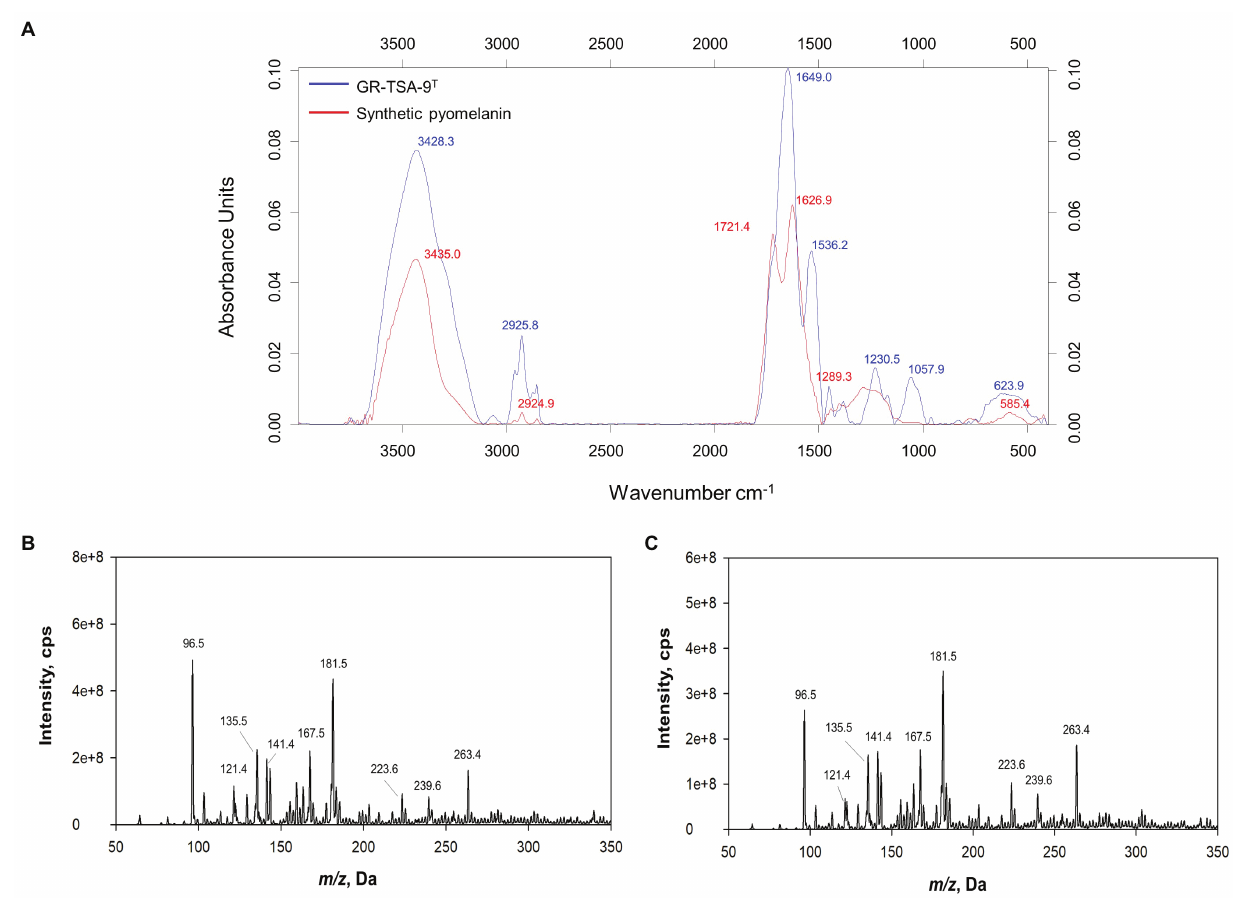
FIGURE 5 | Analysis of pyomelanin from strain GR-TSA-9 T . (A) FT-IR spectrum overlay from synthetic pyomelanin (red line) and purified melanin from strain GR- TSA-9 T (blue line). Electrospray ionization mass spectrometry (ESI-MS) spectra of synthetic pyomelanin (B) and purified bacterial melanin (C) . Nine main peaks ( m/z ration: 96.5, 121.4, 135.5, 141.4, 167.5, 181.5, 223.6, 239.6, and 263.4) are evident in the pigment of synthetic and bacterial melanin.